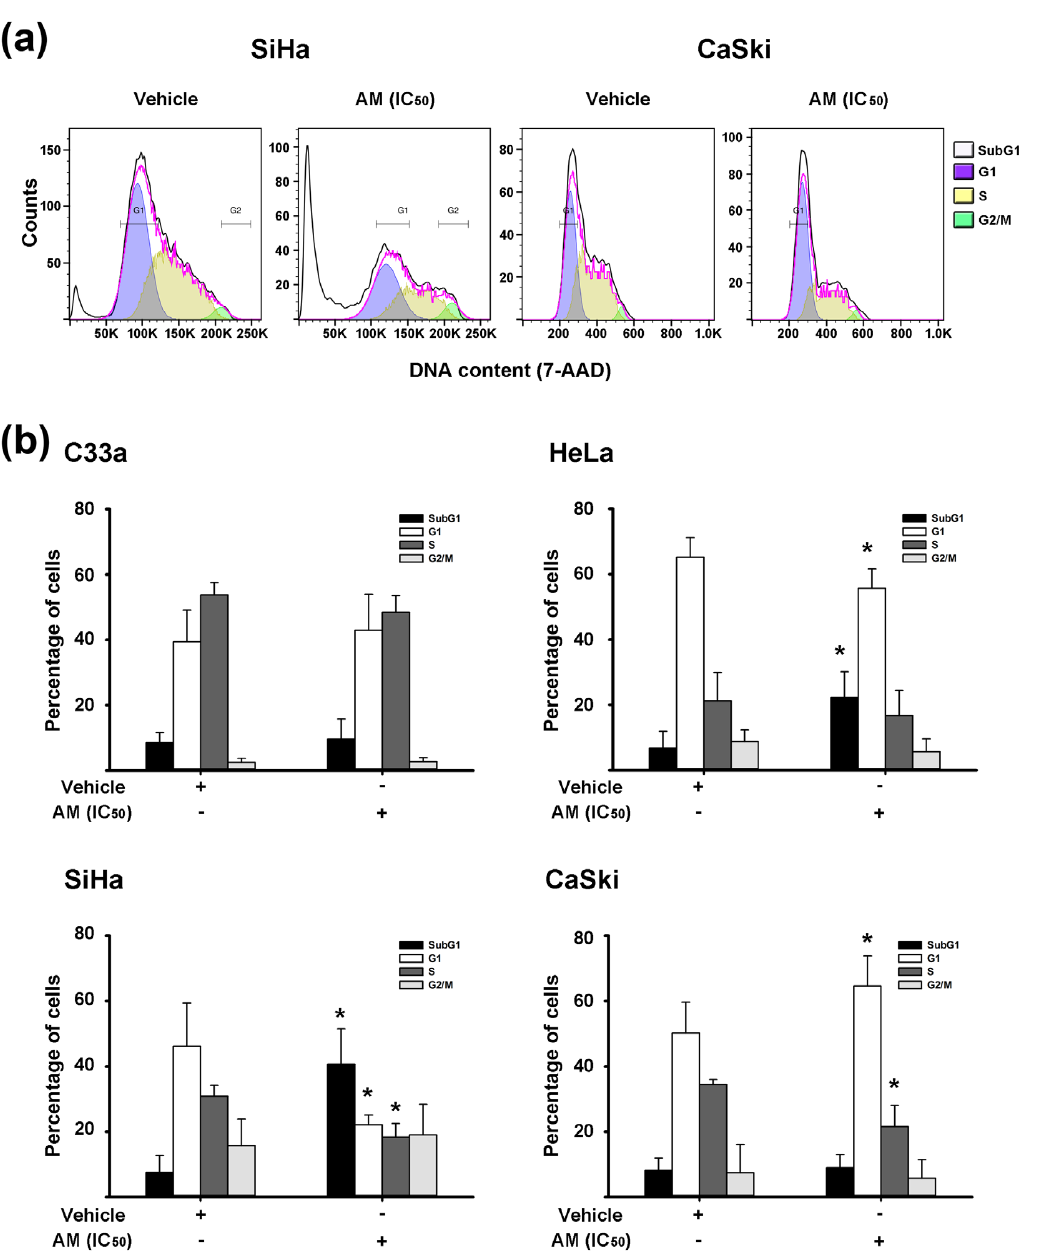
Figure 2. Effects of AM on the cell cycle distribution of cervical cancer cells. Cells were treated with α -mangostin (AM) at its respective inhibitory concentration at 50% (IC 50 ), and after 48 h, the cell cycle distribution was analyzed by flow cytometry. ( a ) Representative flow cytometry histograms of SiHa and CaSki cells treated with either vehicle or AM. The G1-cell cycle phase is shown in purple, the S-region in yellow, and the G2/M in green. The SubG1 subpopulation, indicating cell death, is represented by the white color. The pink line shows how well the mathematical model Dean-Jett- Fox fits the histogram (black line). ( b ) Graphics show the mean percentage of cells ± SD per cell cycle-phase in three replicates of at least three independent experiments. * p < 0.05 vs. vehicle